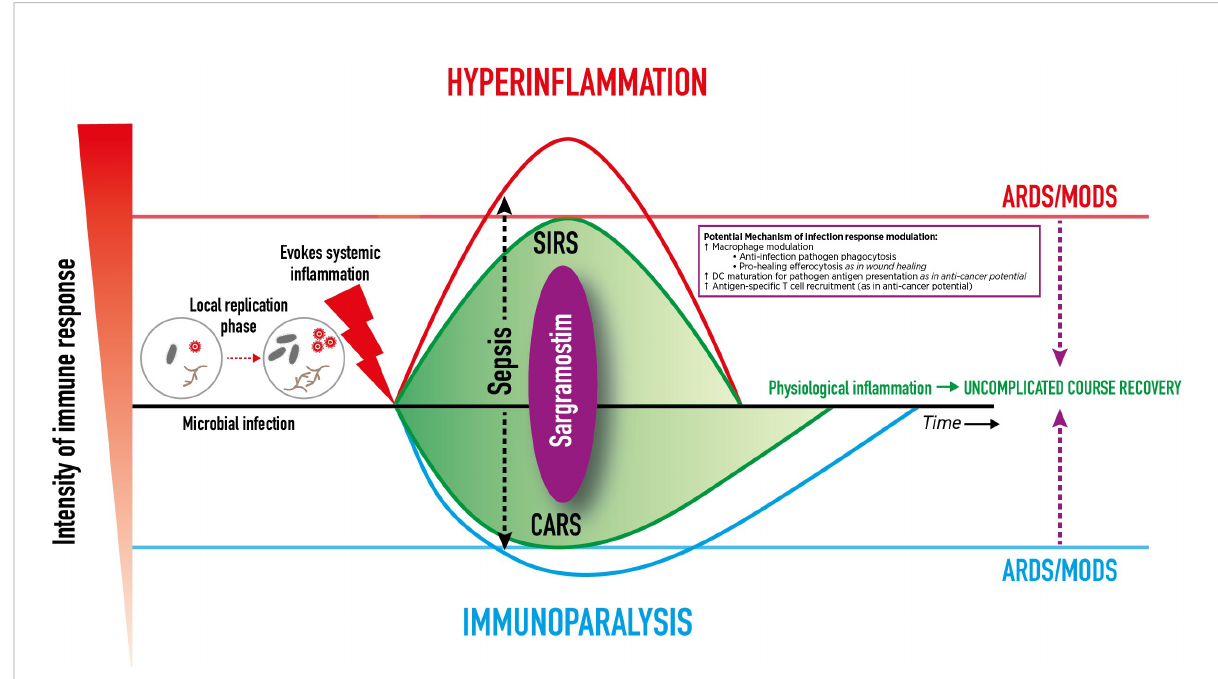
FIGURE 1 Dynamic Clinical Immune Response to Infection. Dynamic Clinical Immune Response to Infection and Potential Sargramostim Effect. After transmission, an infectious pathogen incubates, replicates , and induces systemic in fl ammation . A high pathogen load can overwhelm and dysregulate the innate and adaptive immune systems, spread, and cause life-threatening organ dysfunction. An overly pro-in fl ammatory immune response leads to systemic in fl ammatory response syndrome (SIRS).The compensatory anti-in fl ammatory response syndrome (CARS) slows the immune response. Simultaneous SIRS and CARS are considered normal complementary physiologic mechanisms that balance to restore homeostasis after infection onset. However, complications or dysregulated immune systems can incite excessive SIRS or CARS, skew the balance, and induce damage to vital organs (e.g., lungs, kidneys, heart, GI system, brain) and cause multiple organ dysfunction syndrome (MODS), and death. In the case of respiratory viral infections, damage to the lungs can result in acute respiratory distress syndrome (ARDS). Sargramostim (recombinant human granulocytemacrophage colony-stimulating factor) may mirror the effects of endogenous GM-CSF to modulate the immune response by alveolar macrophage activation, dendritic cell maturation, and antigen-speci fi c T cell recruitment to aid in pathogen clearance. This may mitigate hyperin fl ammation and immunoparalysis to prevent ARDS and other organ